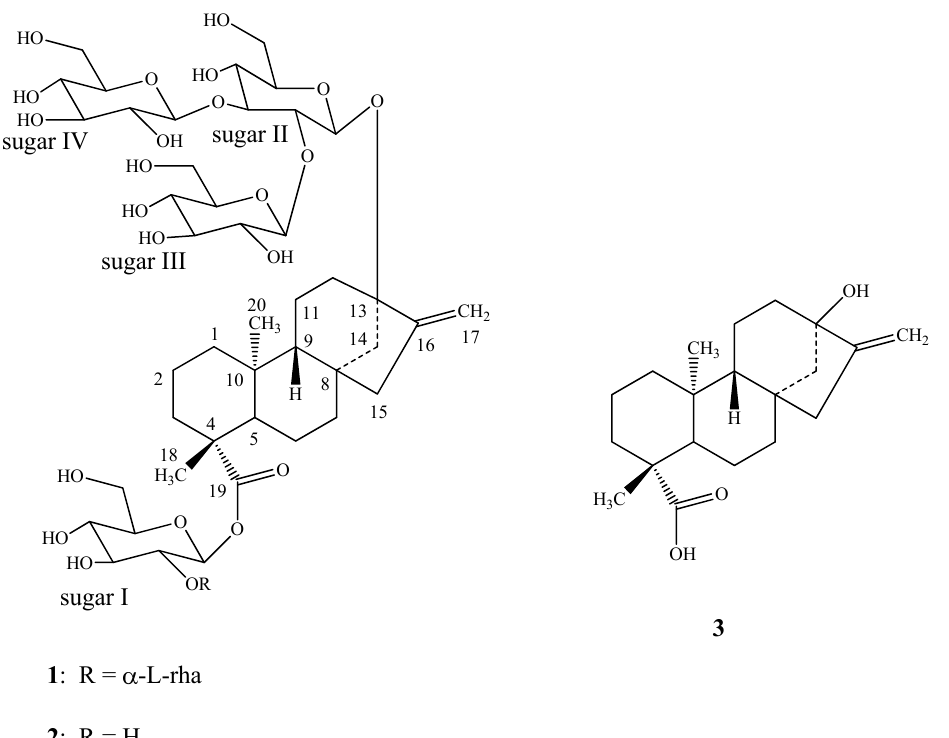
Figure 1. Structure of 1 and other